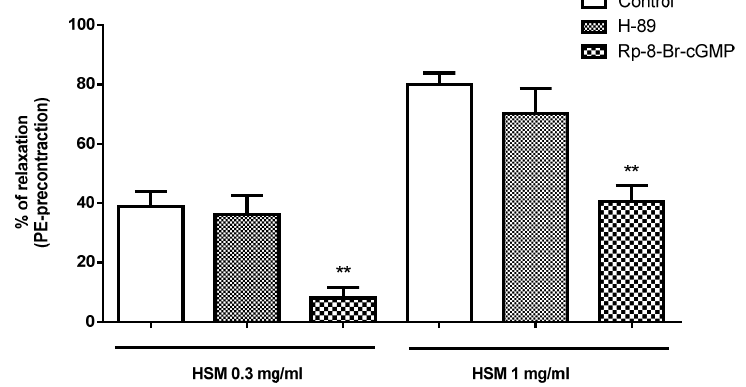
Figure 3. The relaxant effects of H. stoechas extract (HSM; 0.3 and 1 mg/mL) in the absence (control) and presence of the protein kinase A inhibitor H-89 (200 nM) or the protein kinase G inhibitor Rp-8-Br-cGMP (10 μ M) on PE-induced contractions evoked in isolated rat aorta rings (Interaction: F = 0.32, p = 0.7277; Dose: F = 52.40, p < 0.0001, Way: F = 18.42, p < 0.0001). Data points are mean ± SEM ( n = 6–8). ** p < 0.01 vs. control.